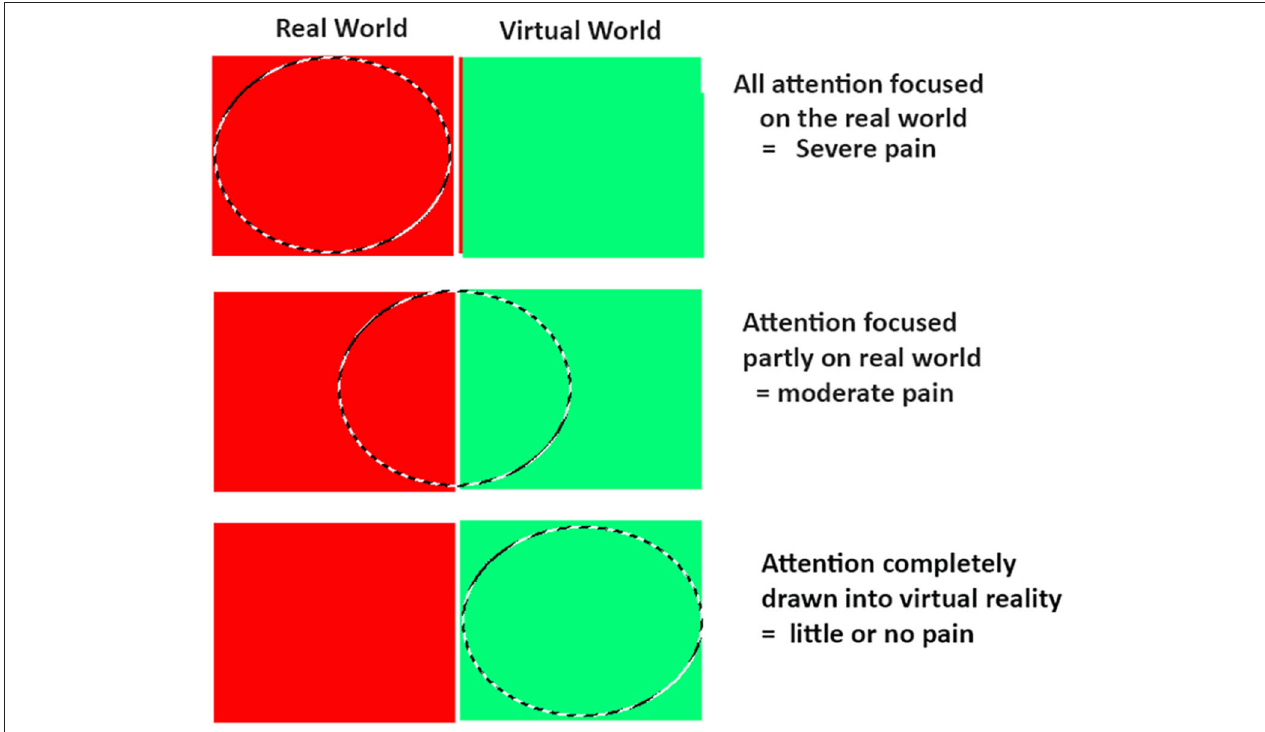
FIGURE 3 | Hoffman et al. (2000) proposed that the patient’s illusion of “being there” in VR, leaves less attention available to process incoming nociceptive signals. Although not conclusive, the current patient’s pattern of results are consistent with an attentional mechanism. Copyright Hunter Hoffman,